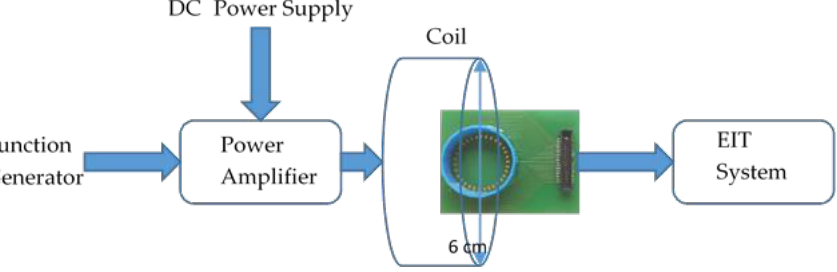
Figure 3. The PCB with 32 electrodes as part of the system. The dimensions of the well are 2.9 cm diameter and 1 cm height. The container material is polylactic acid (PLA).